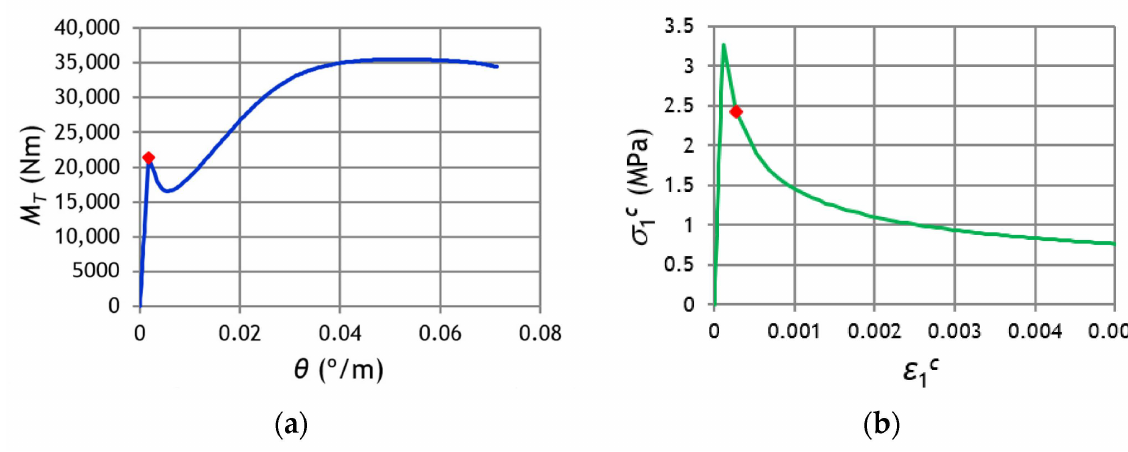
( b ) Figure 6. Location of the effective cracking point. 4. Comparison with experimental results For this study, the experimental results of 103 RC beams tested under torsion were collected from the literature. Both RC beams with plain and hollow rectangular cross sec- tion were considered. These beams were selected based on criteria related to minimum requirements from codes of practice (for instance, the beams should incorporate a mini- mum torsional reinforcement, the spacing between rebars should not exceed the maxi-